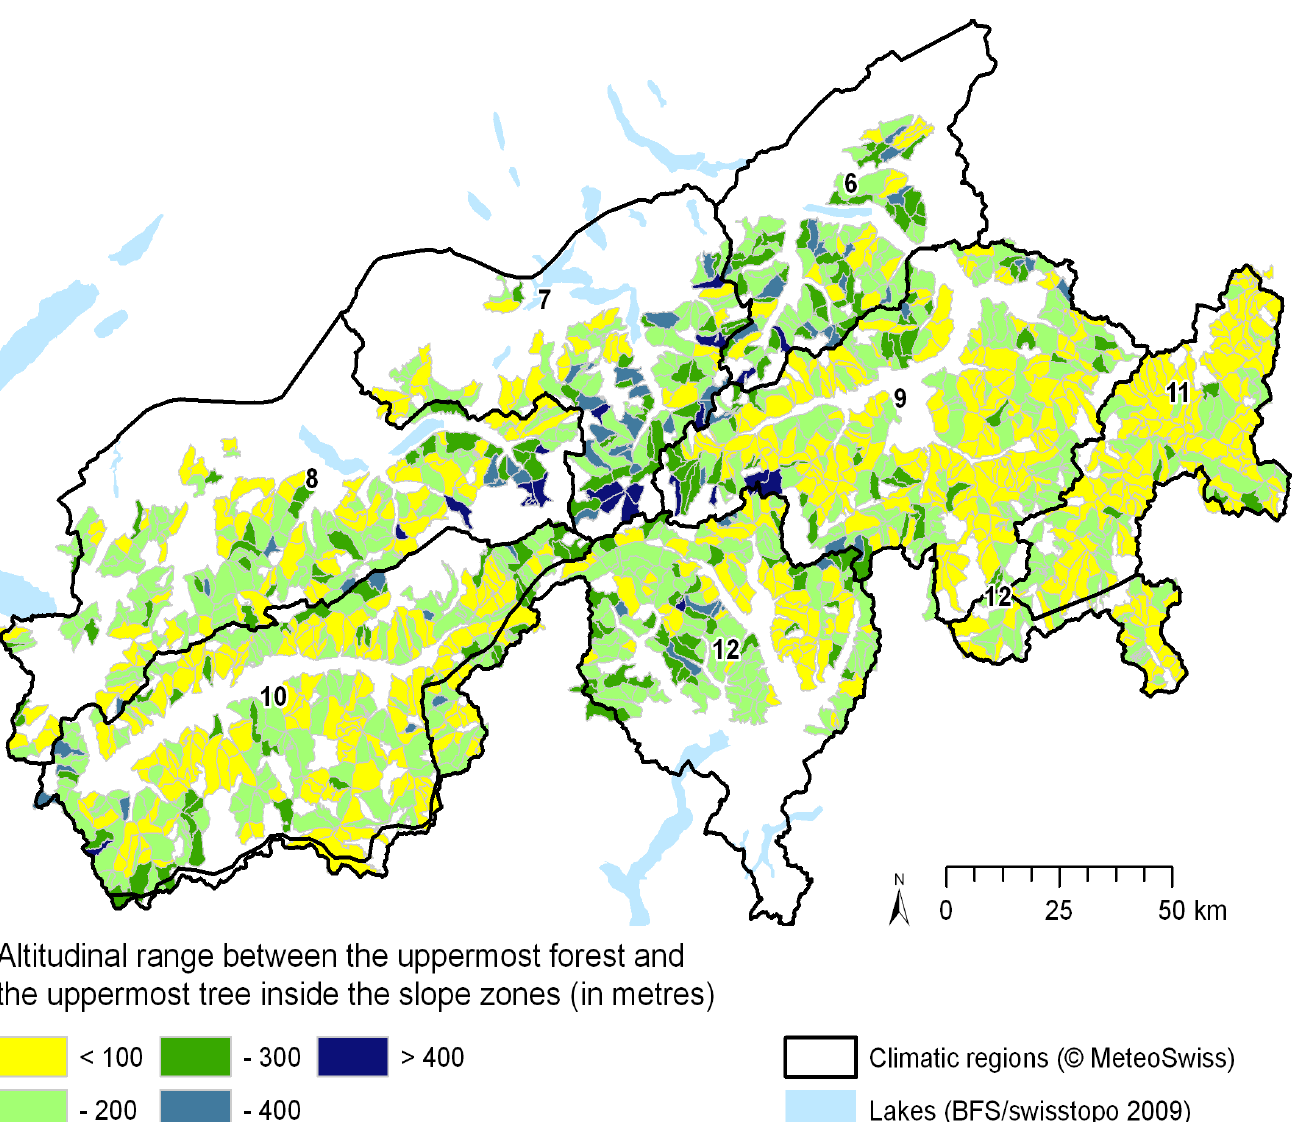
Figure 9. The altitudinal range between the uppermost tree and the uppermost forest was calculated and coloured by slope zones. Only slope zones were considered which are crossed by both the tree and the forest